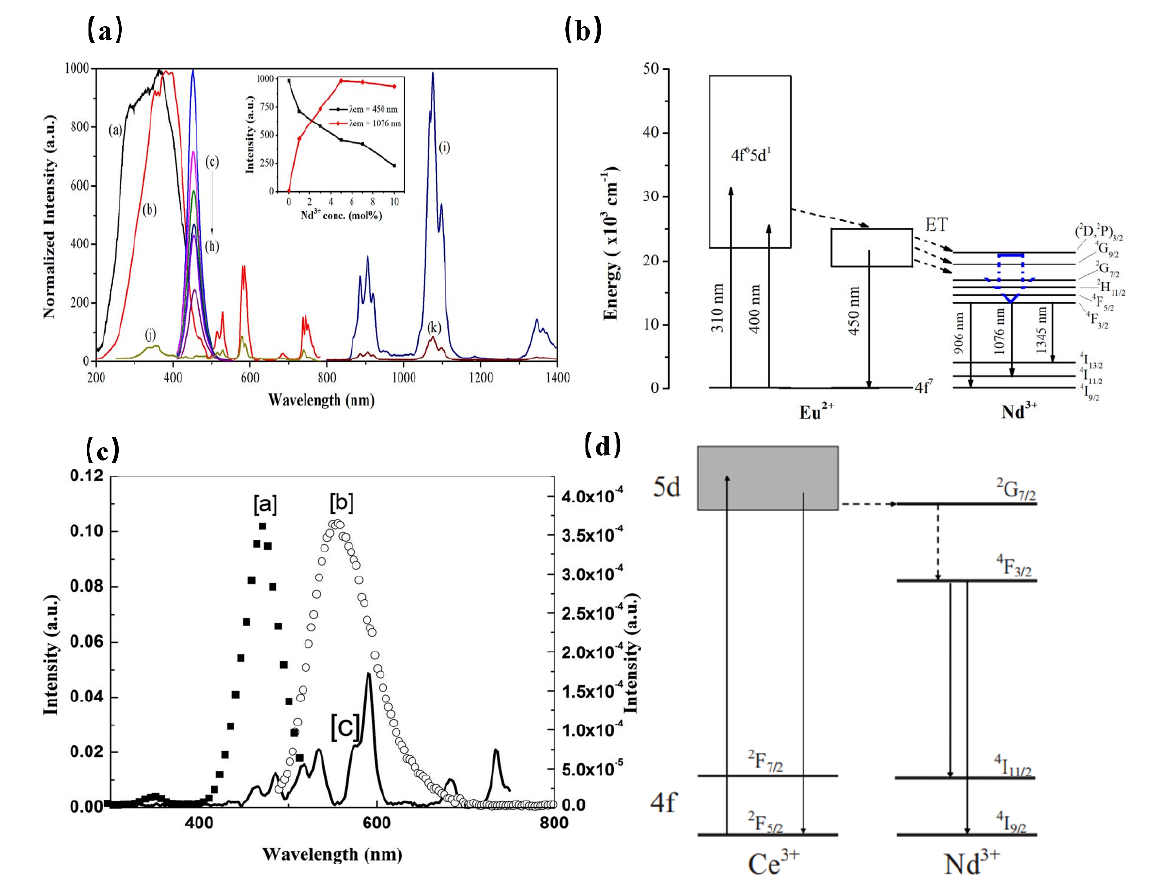
Figure 5. ( a ) PLE (a, Em = 450 nm and b, Em = 1076 nm) and PL (c–i, Ex = 400 nm) spectra of the Ca 2 PO 4 Cl: Eu 2+ , Nd 3+ samples. PLE (j, λ em = 1076 nm) and PL (k, λ ex = 400 nm) spectra Ca 2 PO 4 Cl: Eu 2+ , Nd 3+ samples. ( b ) Schematic energy-level diagram for Eu 2+ and Nd 3+ in the Ca 2 PO 4 Cl phosphor. ( c ) Fluorescence spectra of YAG: Ce and YAG: Nd. (a, PLE spectrum of YAG: Ce Em = 550 nm, b, PL spectrum of YAG: Ce Ex = 476 nm, and c, PLE spectrum of YAG: Nd Em = 1064 nm). ( d ) Schematic energy-level diagram for YAG: Ce 3+ , Nd 3+ .